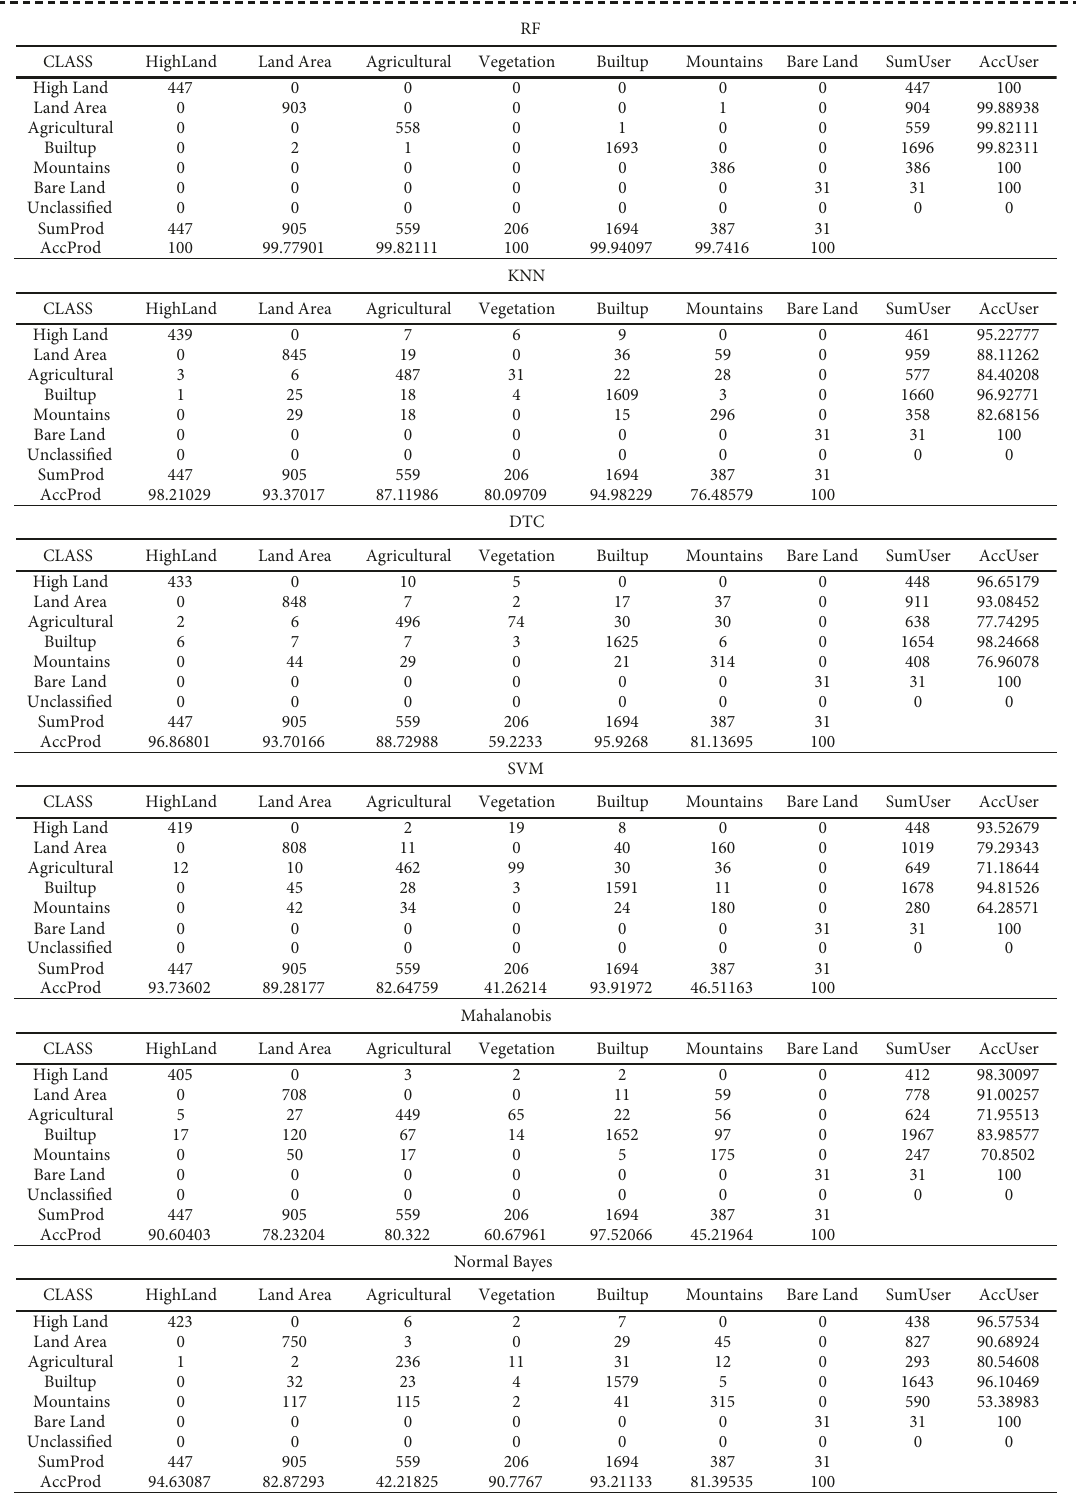
Figure 7: Group 1 confusion matrix tables for machine learning methods of Sentinel-2A